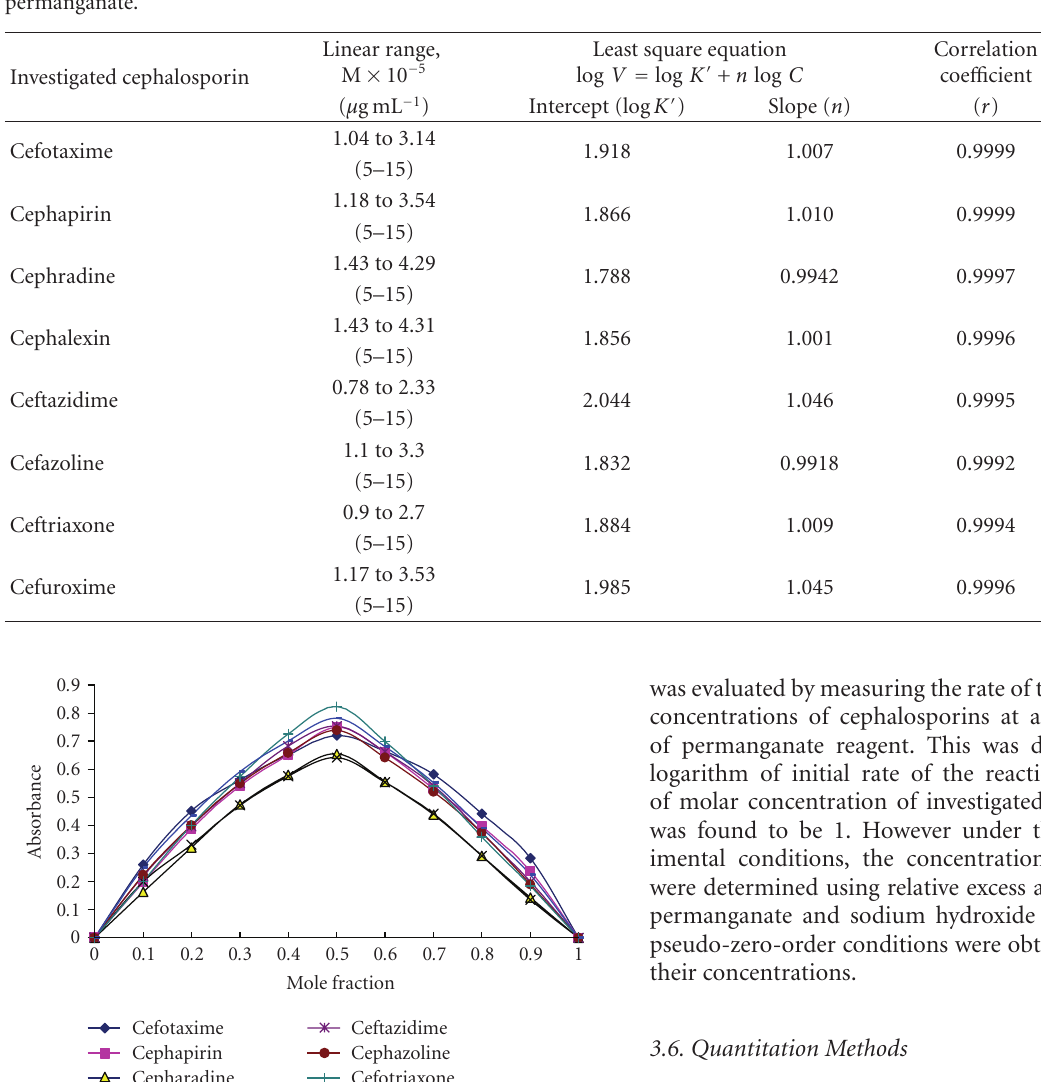
Table 2: Analytical parameters for the initial rate method for determination of investigated cephalosporins with alkaline potassium permanganate.